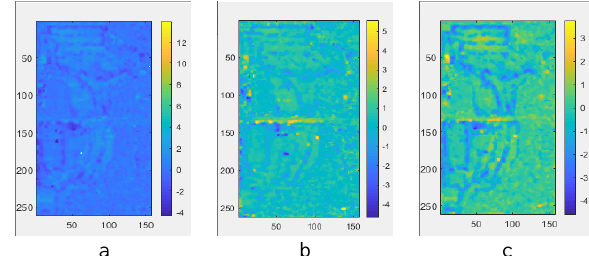
Fig. 8. Change indices in region 2 based on, (a) log-ratio Yamaguchi Odd, (b) log-ratio Yamaguchi Dbl, (c) log-ratio Yamaguchi Vol